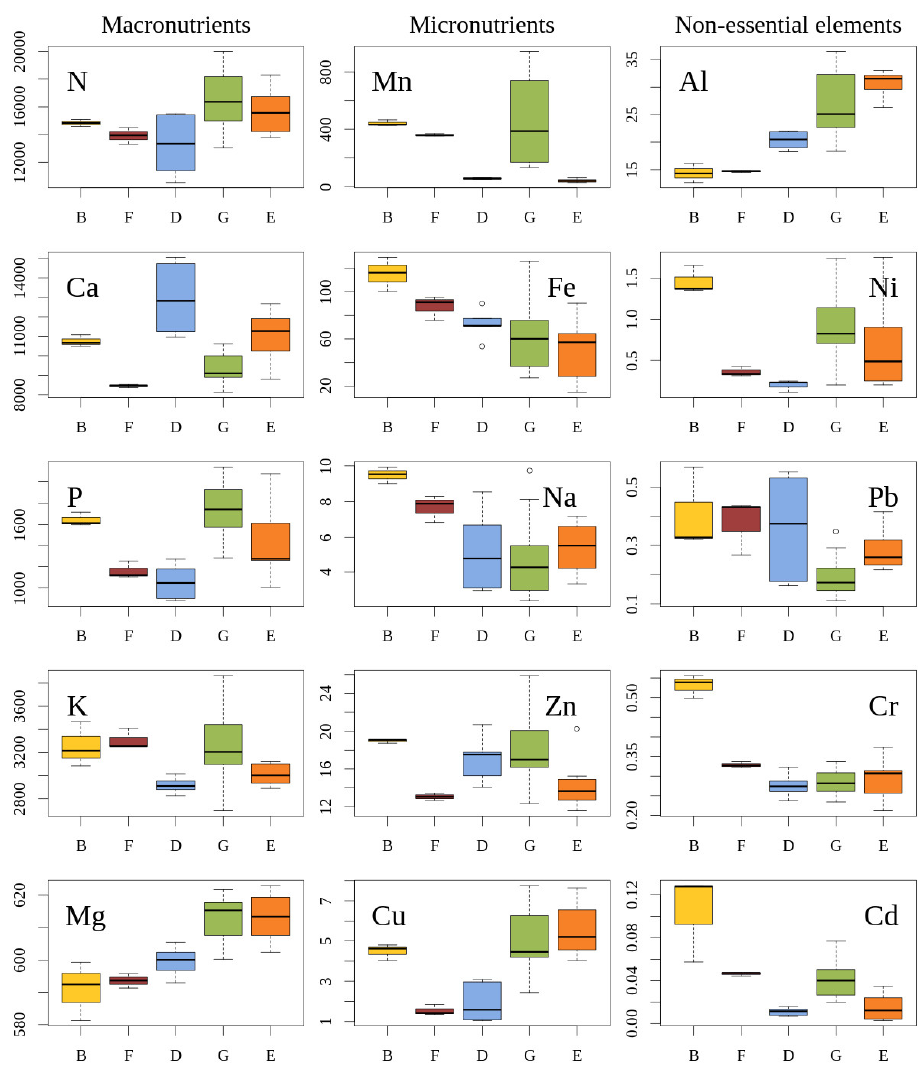
Figure 2. Concentrations ( µ g/g d. m., y axes) of macroelements (N, Ca, P, K, Mg), microelements (Mn, Fe, Na, Zn, Cu), and non-essential elements (Al, Ni, Pb, Cr, Cd) in current-year needles of J. communis from different habitats. X axes—types of habitats: B—coastal brown dunes covered with natural Scots pine forests, F— Juniperus communis scrubs, D—transition mires and quaking bogs, G—subcontinental moss Scots pine forests, E—xero-thermophile fringes. The central line of each box indicates a median value; the boxes, the lower (25%) and upper (75%) quartiles, and the whiskers are from 10 to 90 percentiles (typical range), the points are outliers.